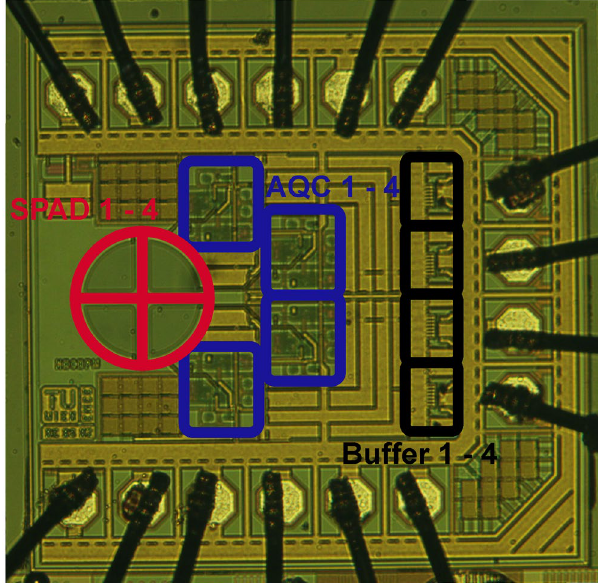
Figure 1. Microphotograph of receiver test chip. The diameter of the 4-SPAD array is 200 µ m with a gap of 34 µ m between the SPADs. The area of this 4-SPAD array is 31,500 µ m² (0.0315 mm²). Each of the four quenchers (AQC) has the dimensions 134 × 130 µ m².